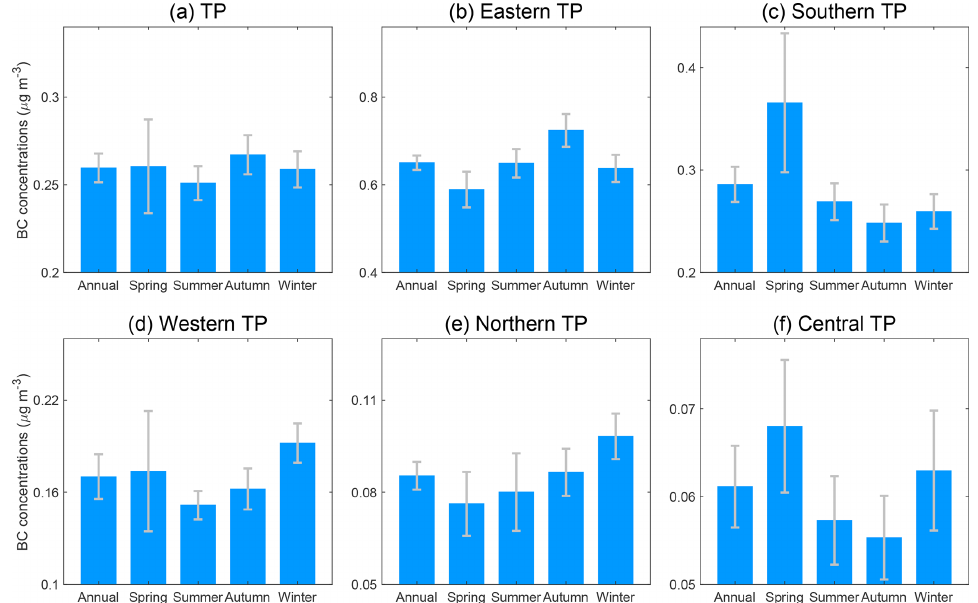
Figure 5. Seasonal variations in surface BC concentrations averaged over the TP and its subregions. The values are 20-year (1995–2014) means from the CTRL simulation. The error bar indicates the standard deviation. Note that the y scales are different for different subregions, ranging from the largest in the eastern TP to the smallest in the central TP.